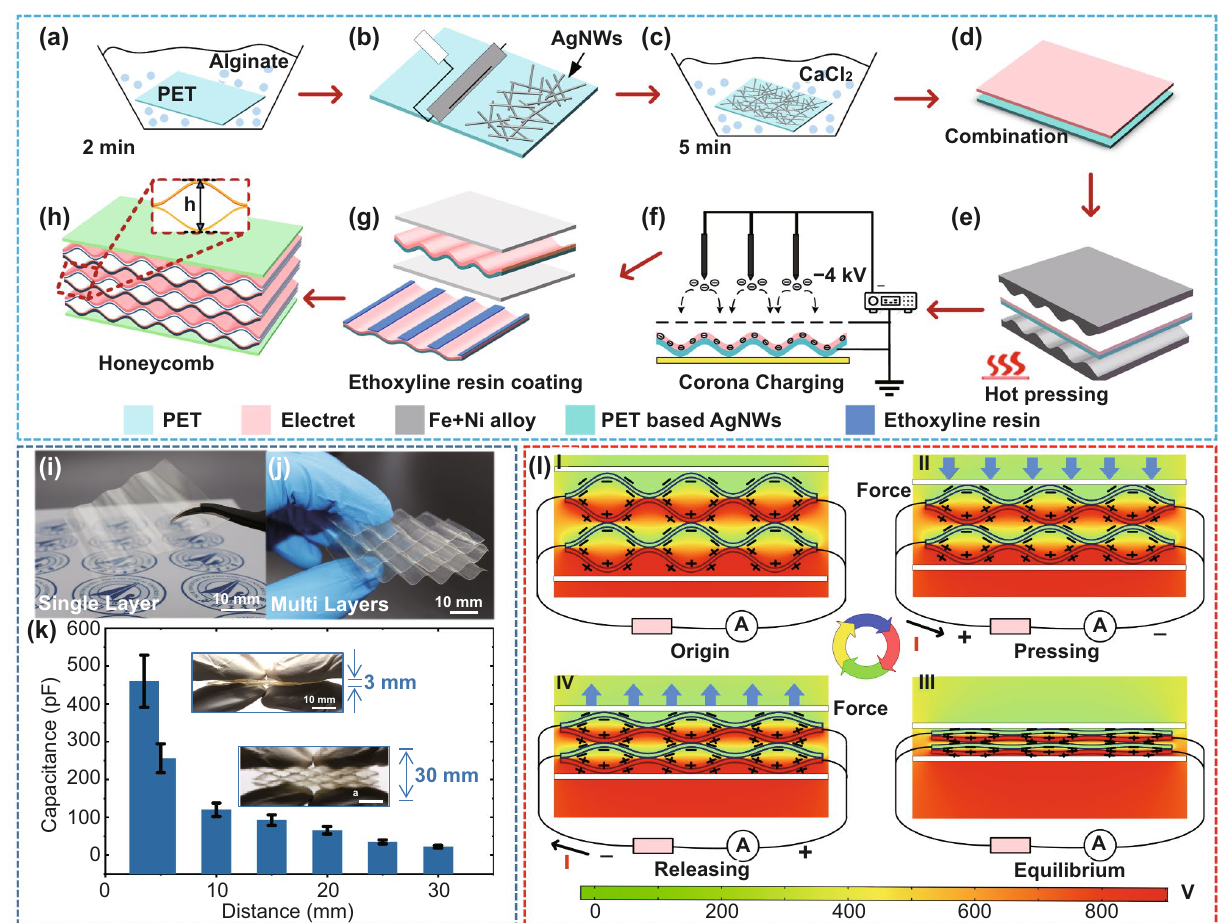
Fig. 2 Fabrication processes and working mechanisms of the proposed h-TENG: a PET thin film is treated with alginate for 2 min. b AgNWs are pressed onto the surface of PET by rolling process. c CaCl 2 treatment is used to ‘weld’ the AgNWs onto the surface of PET thin film. d FEP electret thin film is bonded onto PET/AgNWs film surface with ethoxylate resin. e A single-wavy structure is formed using iron alloy templates through high-temperature molding process. f A corona discharging process is used to implant charge into FEP electret thin films. g Honeycomb structures are assembled by stacking multilayered PET/AgNWs/FEP composite together. h–j schematic illustration and optical photographs of the fabricated h-TENG device. k Capacitance values change from 20 to 480 pF when the height of h-TENG changes from 3 cm to 3 mm with stacking triple-layer wavy structure. l Electric field and charge redistribution within four stages of h-TENG in a compress-release cycle: I Initial stage of original state. II Electrostatic induction by electrets when two electrodes get close to each other under external compressive force. III Contact triboelectrification when two electrodes get intimate contact with each other. IV Charge flows back when